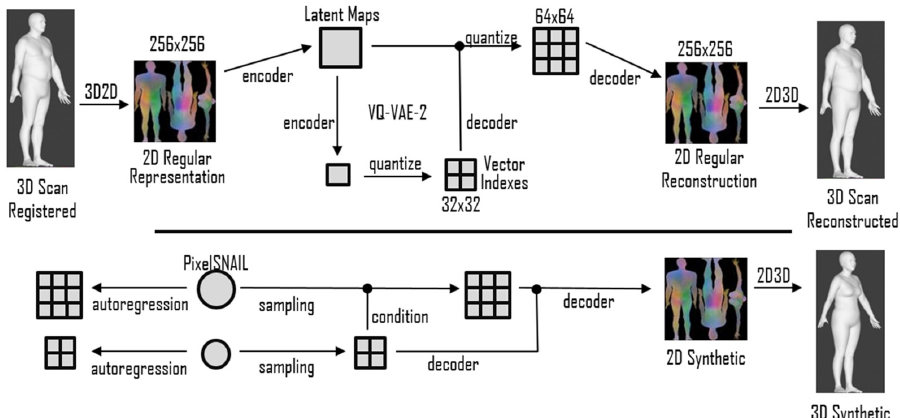
Figure 3. Method’s flowchart for a 3D body example. The registered 3D scans were first converted into a regular 2D image to feed the VQ ‐ VAE ‐ 2 autoencoder. The PixelSNAIL later learned a prior over the latent space, sampled novel synthetics codes, and decoded them into new geometric images and, subsequently, to 3D scans.